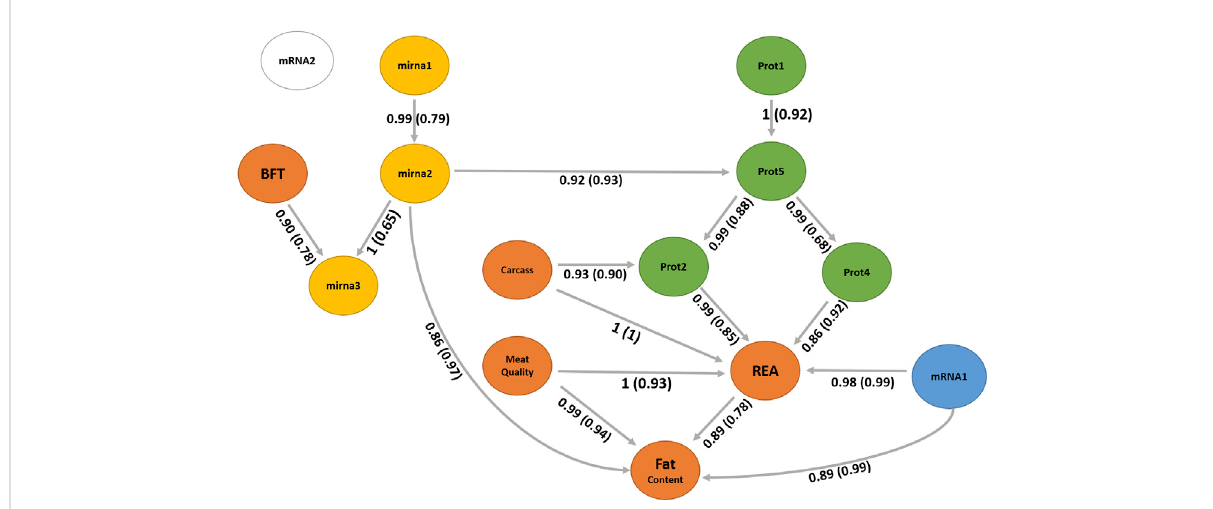
FIGURE 7 Bayesian network between latent variables based on the score-based (hill climbing and tabu) algorithms. The quality of the structure was evaluated by bootstrap resampling and model averaging across 1,000 replications. Orange nodes: phenotype latent variables; yellow nodes: miRNA latent variables; greennodes: protein latent variables; blue node: gene expressionof mRNA1 module (WGCNA); and white node: gene expressionof mRNA2 module (WGCNA). The labels of the arcs correspond to the strength and direction (in